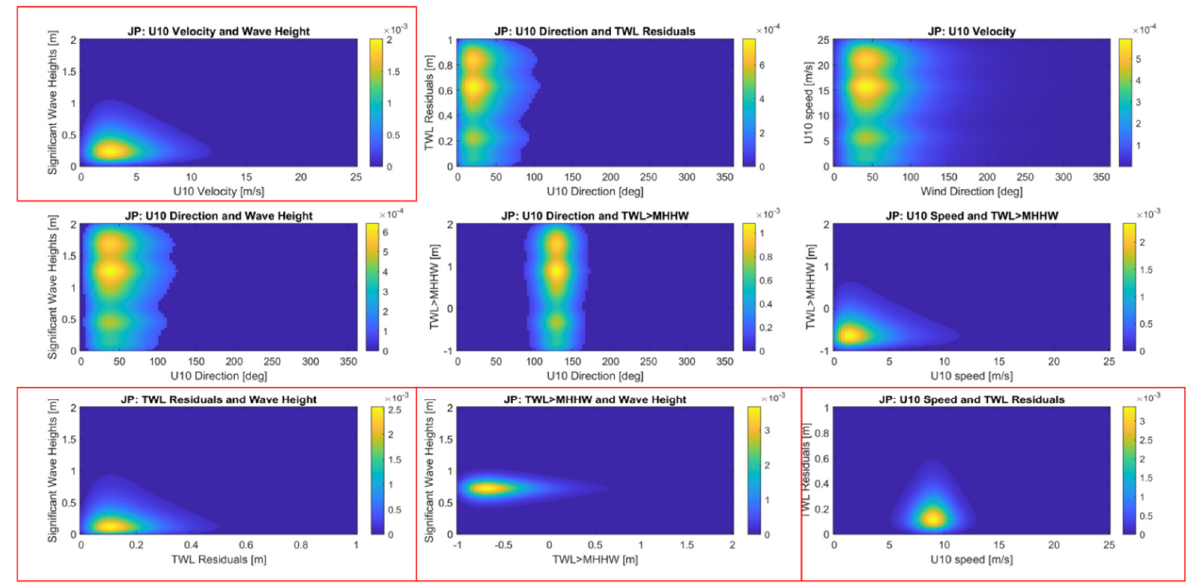
Figure 8. JP heat maps for the combinations of the following parameters: U 10 velocity, H s , TWL res , and TWL MHHW . The distributions consisted of field data from 2015 to 2019 for the water level and wind velocity, while the wave heights originated from in situ acoustic deployments. The heat maps surrounded in red boxes correspond to the JP tables in Appendix B.